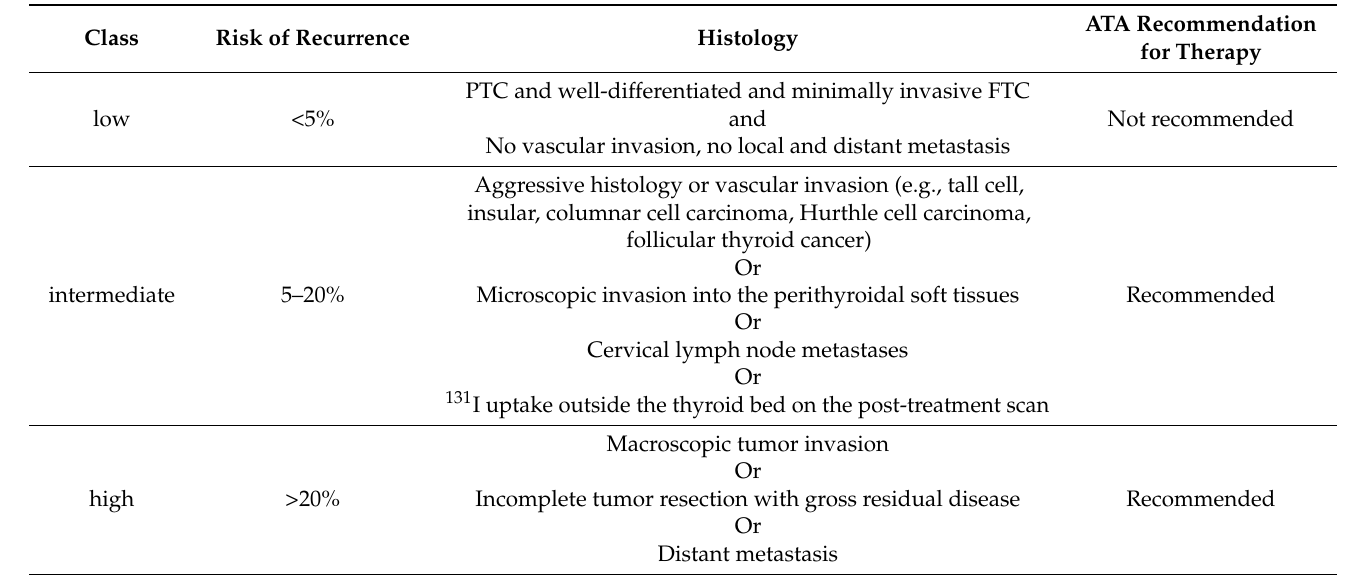
Table 2. ATA risk of recurrence classification and corresponding ATA recommendation for RAIT